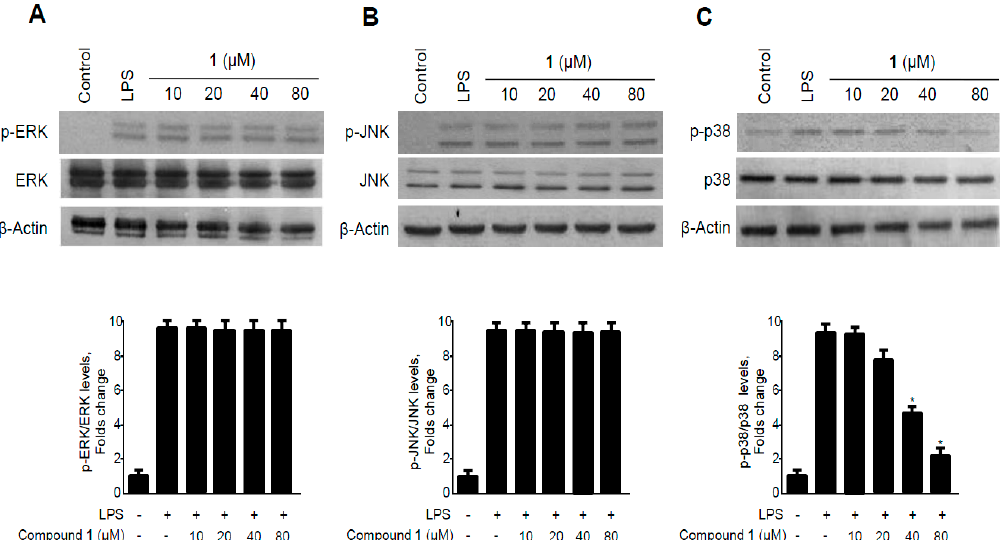
Figure 9. Effects of methylpenicinoline ( 1 ) on ERK, JNK, and p38 MAPK phosphorylation and protein expression in RAW264.7 macrophages. Cells were pre-treated for 30 min with the indicated concentrations of 1 and stimulated for 30 min with LPS (500 ng/mL) ( A – C ). The levels of (A) phosphorylated-ERK (p-ERK); (B) phosphorylated-JNK (p-JNK); and (C) phosphorylated-p38 MAPK (p-p38 MAPK) were determined by western blotting.